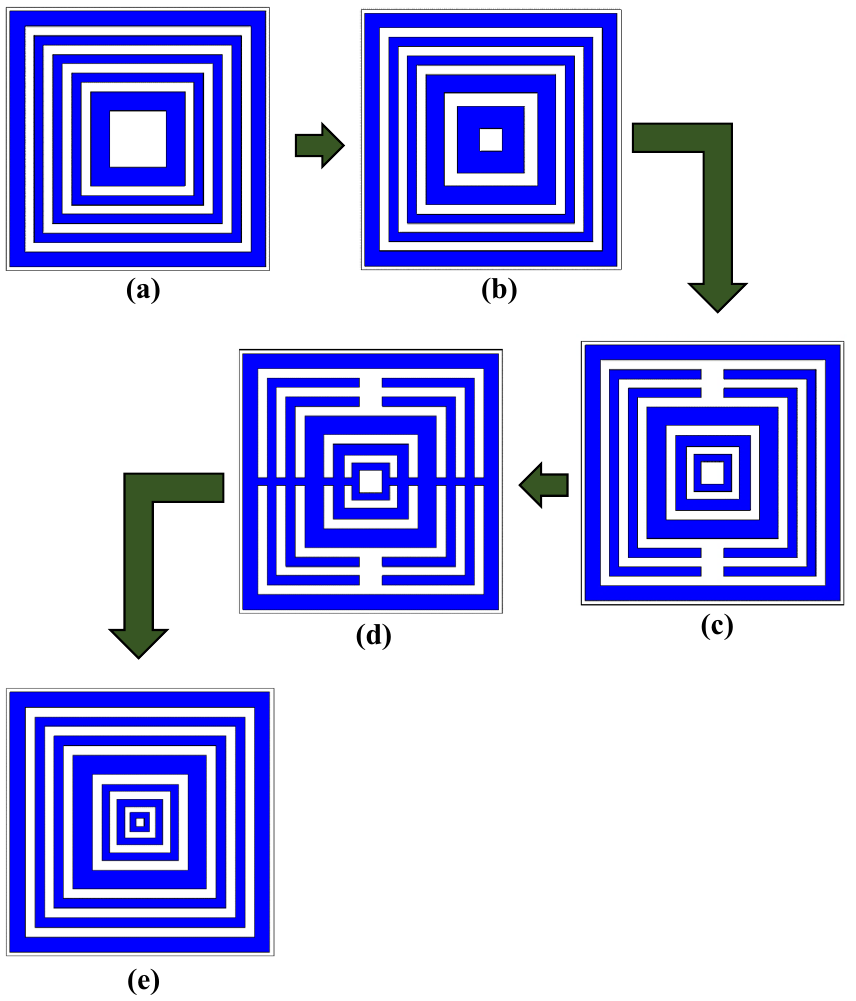
Figure 4. Several square-shaped metamaterial structures: ( a ) DS 1, ( b ) DS 2, ( c ) DS 3, ( d ) DS 4, ( e )